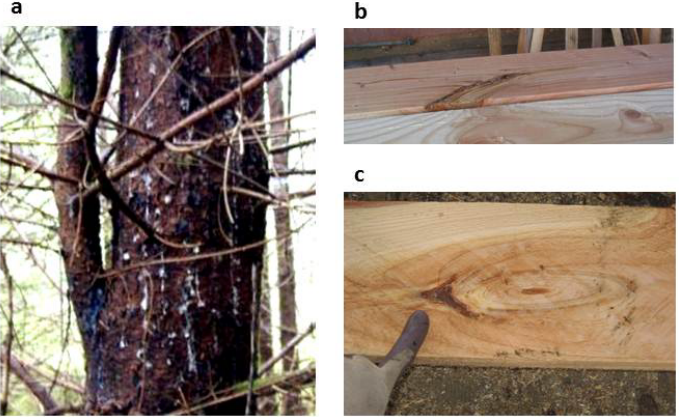
Figure 12. Ramicorn branch on Douglas-fir tree ( a ) and implications for solid wood products manufactured from stem with ramicorn branch ( b , c